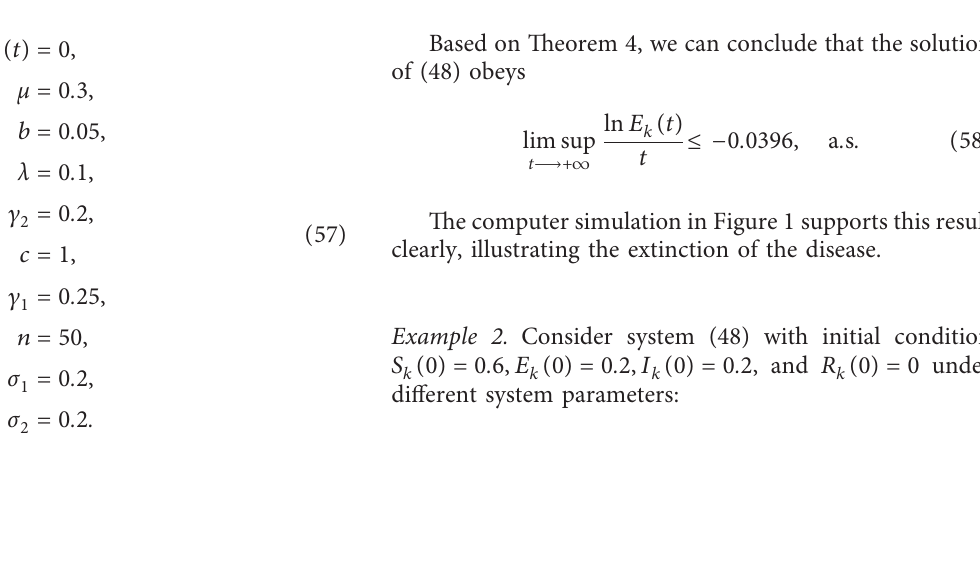
Figure 2: Under the initial conditions given in Example 2, the time evolution of each state mean in the complex network in the stochastic model and the deterministic model,